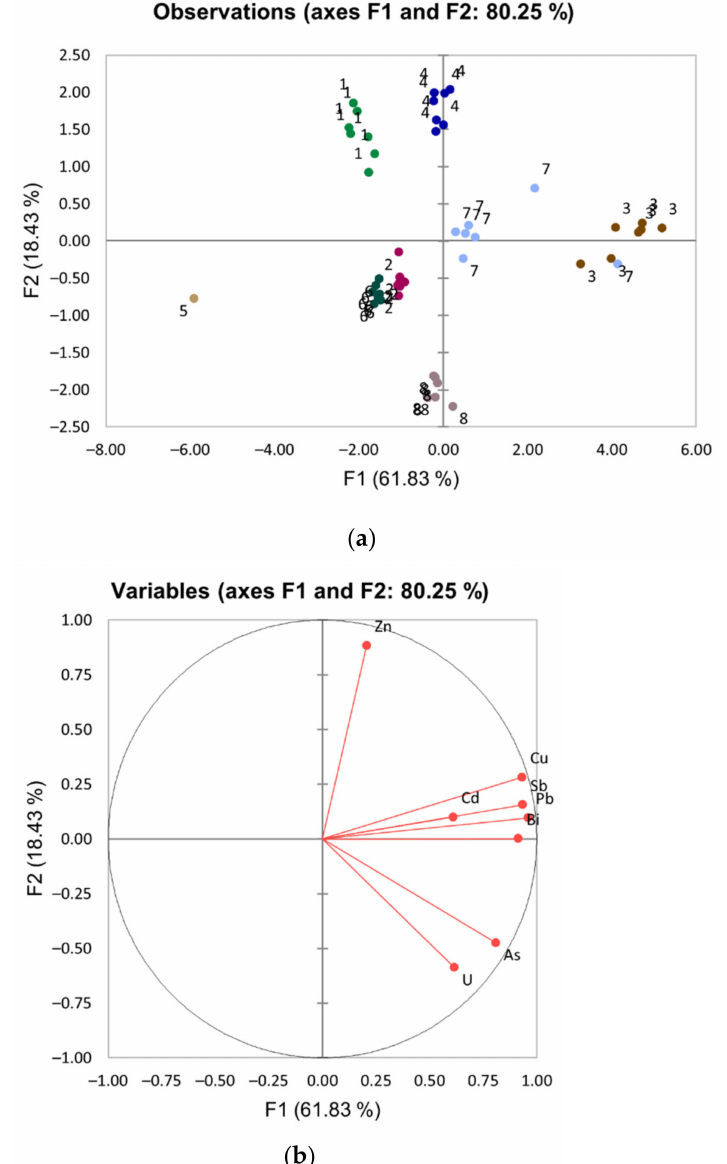
Figure 3. The result of the PCA analysis presented as a score plot ( a ) and a loading plot ( b ). Each sampling point in the score plot is labeled with its site number (see Figure 1). To reduce the influence of extreme values, data were log-transformed before performing PCA. The first component explains 61.83% of the variability, whereas the second component explains 18.43%. Groupings of data on the score plot may indicate two or more separate distributions in the data. Compared with the other samples, sample 5 ( n = 1) contains large amounts of carbonates. The lengths of the arrows in the loading plot represent how well the variables explain the variation of the data. Arrows pointing in the same direction correlate positively, whereas arrows in the opposite direction correlate